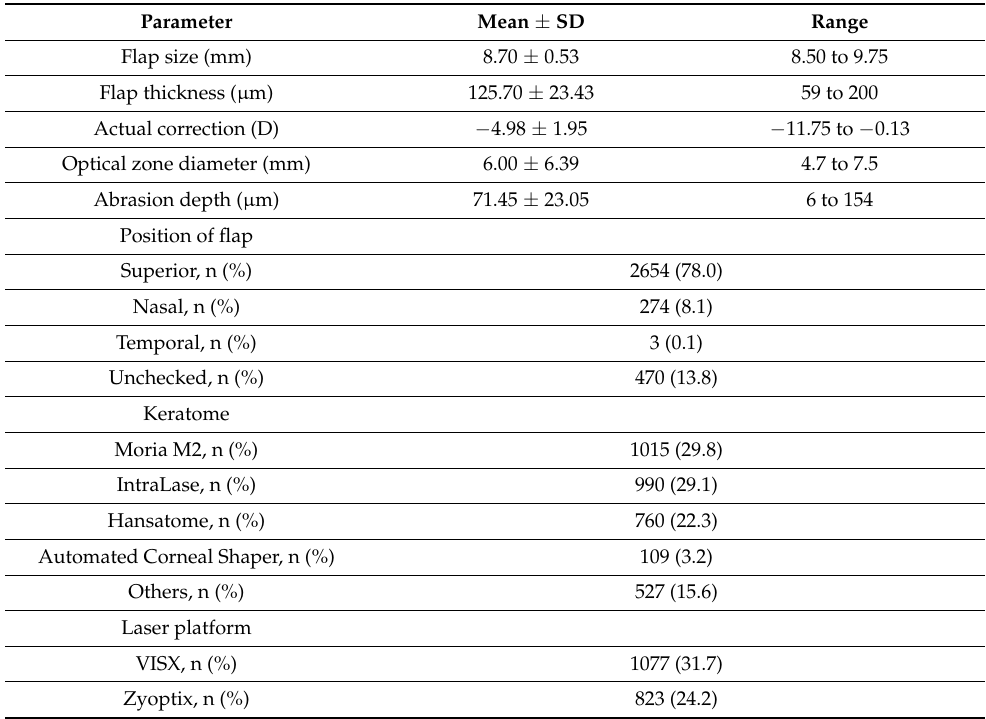
Table 1. Intraoperative parameters (n =